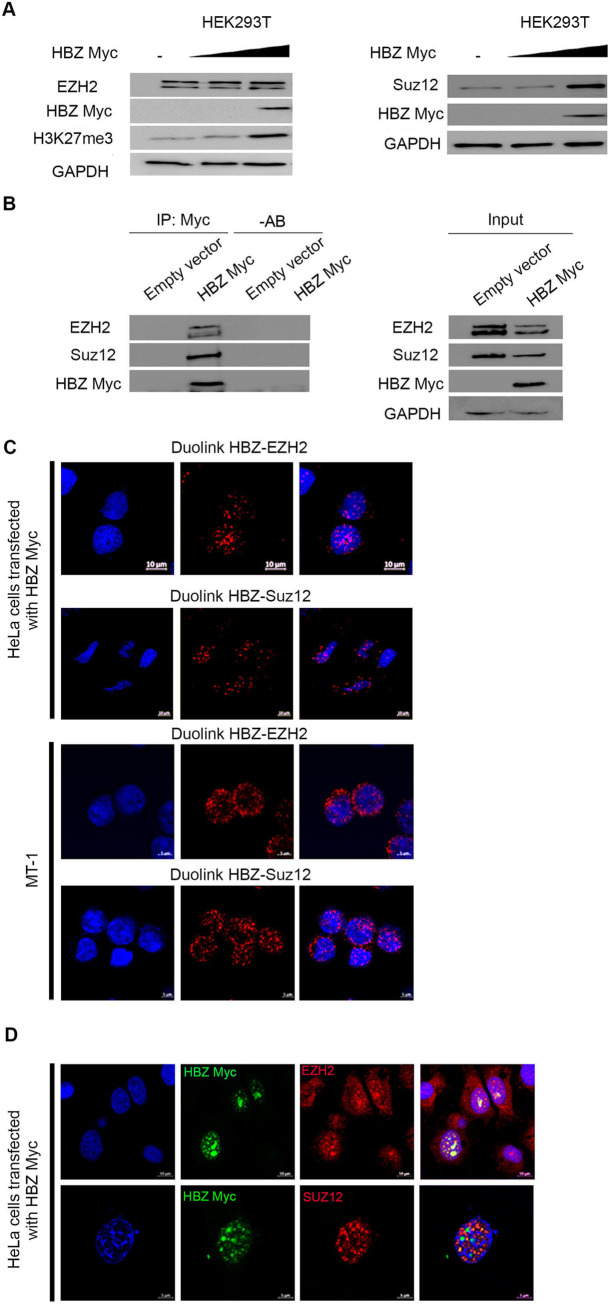
HBZ interacts with PRC2 components EZH2 and SUZ12 and is associated with H3K27me3 accumulation in human cells.(A) HEK293T cells transiently transfected with Myc-HBZ. Western blot was performed with indicated antibodies. (B) HEK293T cells transiently transfected with Myc-HBZ. Myc immunoprecipitates (IP: Myc) were blotted against EZH2, SUZ12 and Tax (Left panel).–AB represents a control with no antibody. Corresponding control cell lysates are shown as indicated (Right panel). (C) HBZ-EZH2 and HBZ-SUZ-12 interactions detected by Duolink Proximity Ligation [73] assay in HeLa cells transfected with HBZ (Scale bar 10 μm), or MT-1 expressing endogenous HBZ. Nuclei were stained with 4,6 diamidino-2-phenylindole (DAPI) (blue). (Scale bar 5 μm). (D) Confocal microscopy (Z-Stacks) of HeLa cells transiently expressing Myc-HBZ, and showing partial co-localization of HBZ-EZH2 (Upper panel) and HBZ-SUZ12 (Lower panel). Nuclei were stained with 4,6 diamidino-2-phenylindole (DAPI) (blue) (Scale bars 10μm and 5μm respectively).